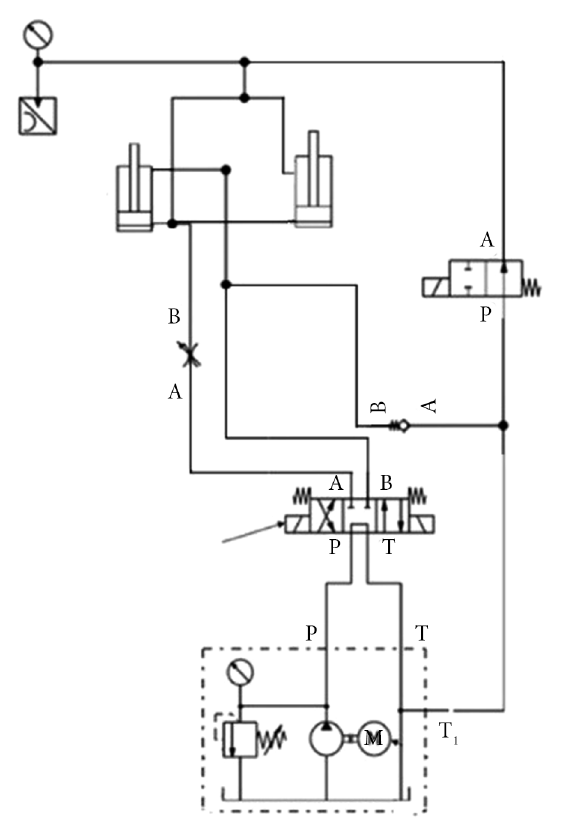
Fig. 7. Hydraulic circuit of the torque generator